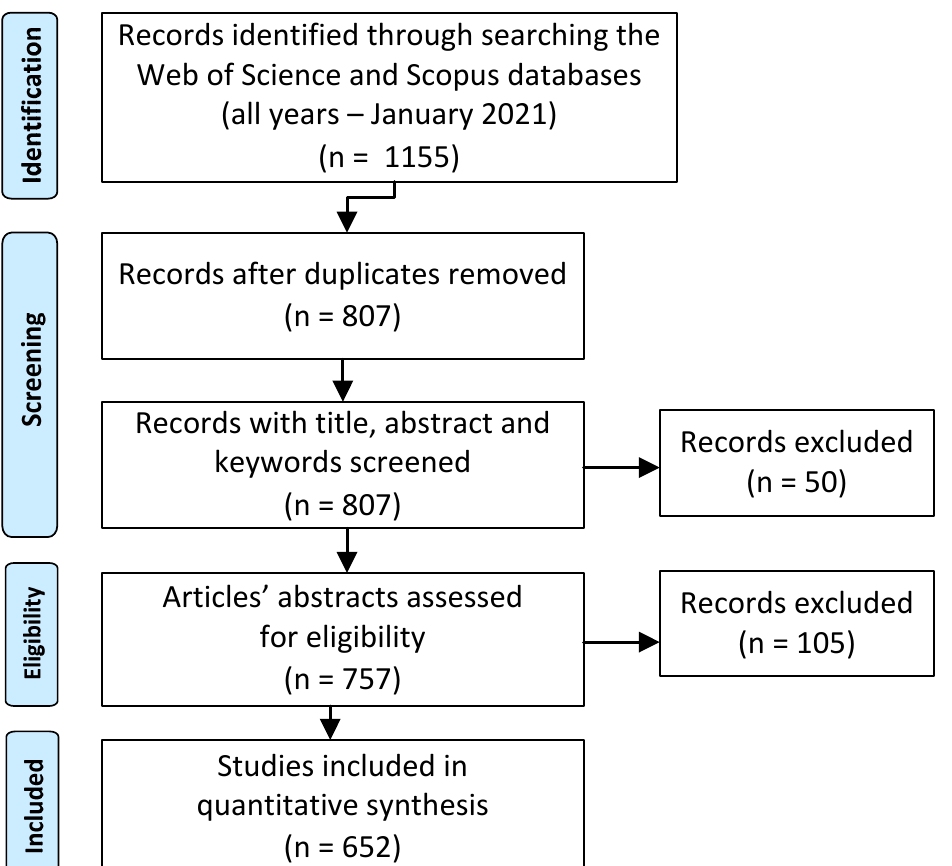
Figure 1. The PRISMA flow diagram (according to [45]) of the current SMS.